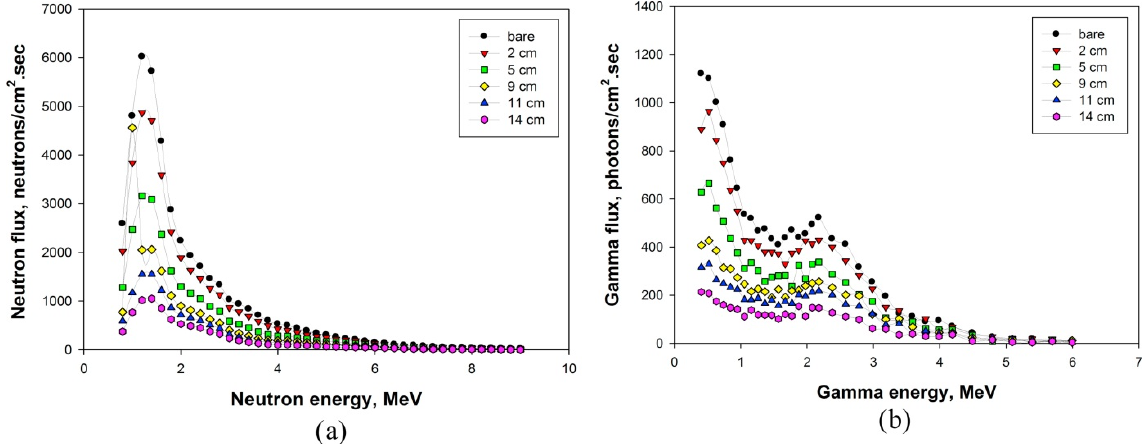
Figure 8. ( a ) Quick neutron spectra in dolomite concrete at different thicknesses. ( b ) Total ray spectra in dolomite concrete at different thicknesses [67].